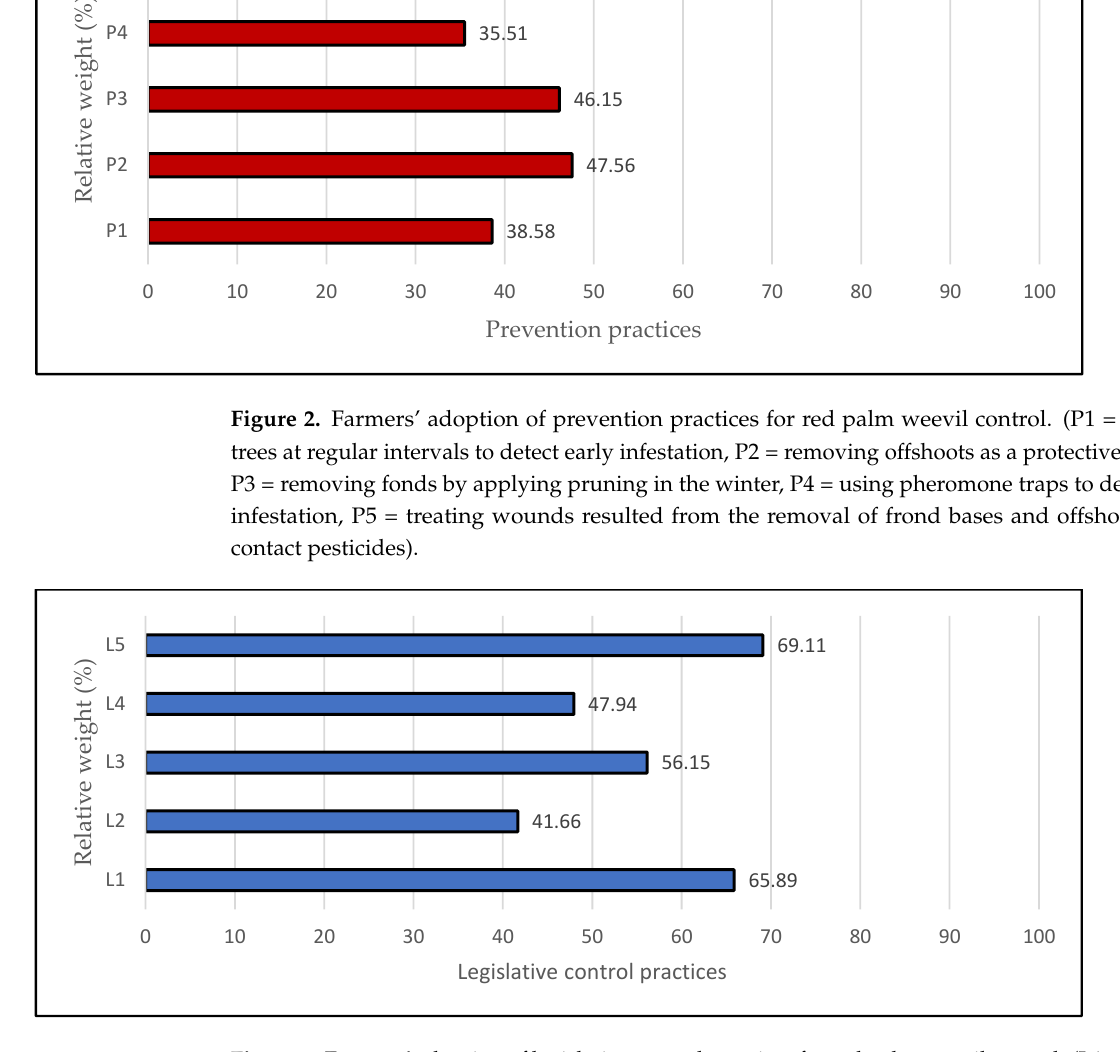
Figure 4. Farmers’ adoption of cultu ral practices for red palm weevil control. (C1 = adhering to the time and depth specified for planting offshoots, C2 = applying moderate irrigation to reduce hu- midity on farms, C3 = adhering to good plowing before planting, C4 = maintaining the recom- mended distance between trees). The findings also revealed that three practices out of the six mechanical control prac- tices examined in this study were moderately adopted by the farmers, while the other practices were considered as having a low level of adoption (Figure 5). The mechanical control practices with the highest relevance rankings in the order of their adoption were eradicating infested palms (61.92%), removing weeds and dry trunks and disposing of them (49.61%), closing all openings on the trunks of palms (44.35%), scraping infested areas until healthy tissue is exposed (42.69%), removing infested or dead trees and the pruning products on neglected farms (40.38%), and covering the roots of small trees with soil to a height of 20 cm (37.69%). However, the assessment of the three statements per- taining to chemical control practices (Figure 6) demonstrates that farmers considered the adoption of chemical control practices (i.e., dusting farms, spraying pesticides of various quantities and qualities within the specified time, and spraying according to the extension recommendations) as being a low-level requirement (relative weight < 50%).